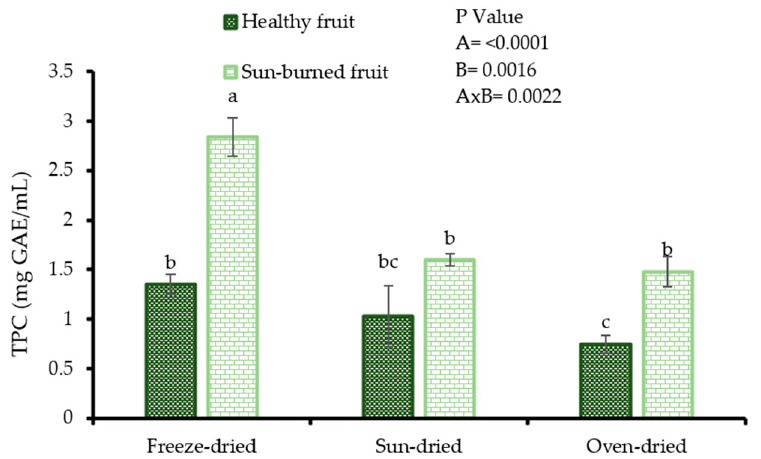
Figure 2. Total phenolic content (TPC) of oil from seeds of healthy and sun-burned fruits and dried under different drying methods. Factorial ANOVA was performed for Factor A (fruit quality) and Factor B (seed drying method). Columns followed by different letters are significantly different ( p < 0.05) according to Duncan’s multiple range test. Vertical bars indicate the standard deviation of the